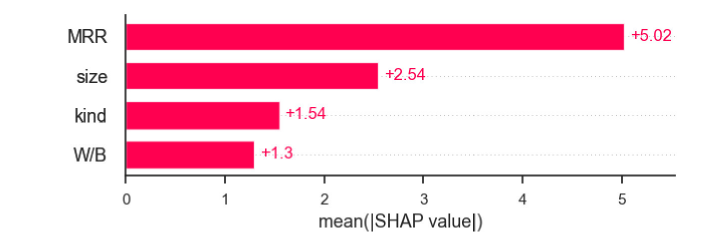
Figure 10. Individual interpretation of SHAP for a sample.